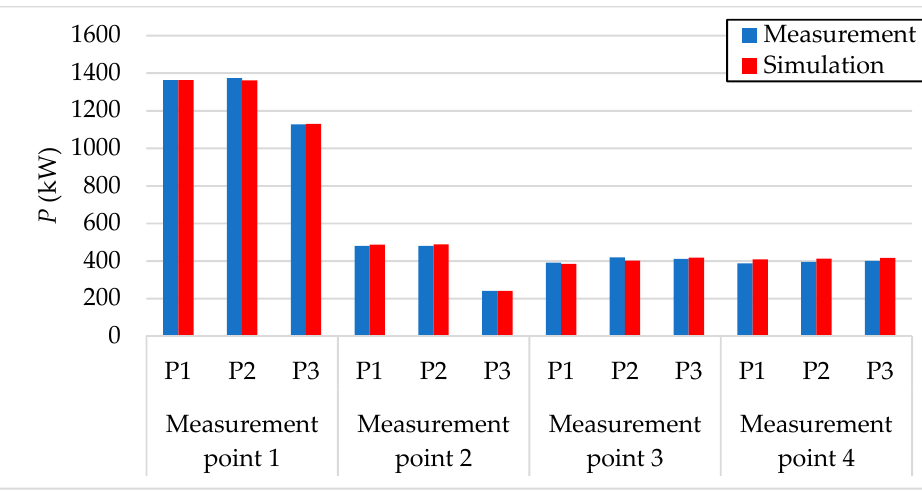
Figure 34. Active power levels at the measurement points in the distribution grid.